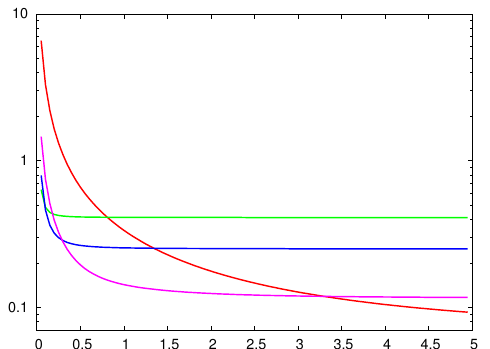
Fig. 17. Evolution of the ratio output noise/input noise depending on the value of input noise for strongly correlated noise ( β = 2). Red curve: fusion; green curve: median filter with 3 × 3 neighbourhoods; blue curve: median filter with 5 × 5 neighbourhoods; purple curve: median filter with 11 × 11 neighbourhoods. For large input noises fusion performs better than the others; the crossover points occur for input noise levels of about 0.5, 0.55, and 0.65,